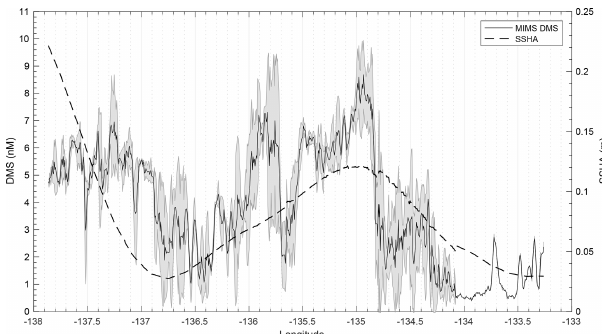
Figure 5. Line plot of sea surface height anomaly (SSHA) on 15 July 2016 and observed DMS concentrations between 14 and 16 July 2016 along T1. DMS along the T1 transect is highest in those areas influenced by positive SSHA